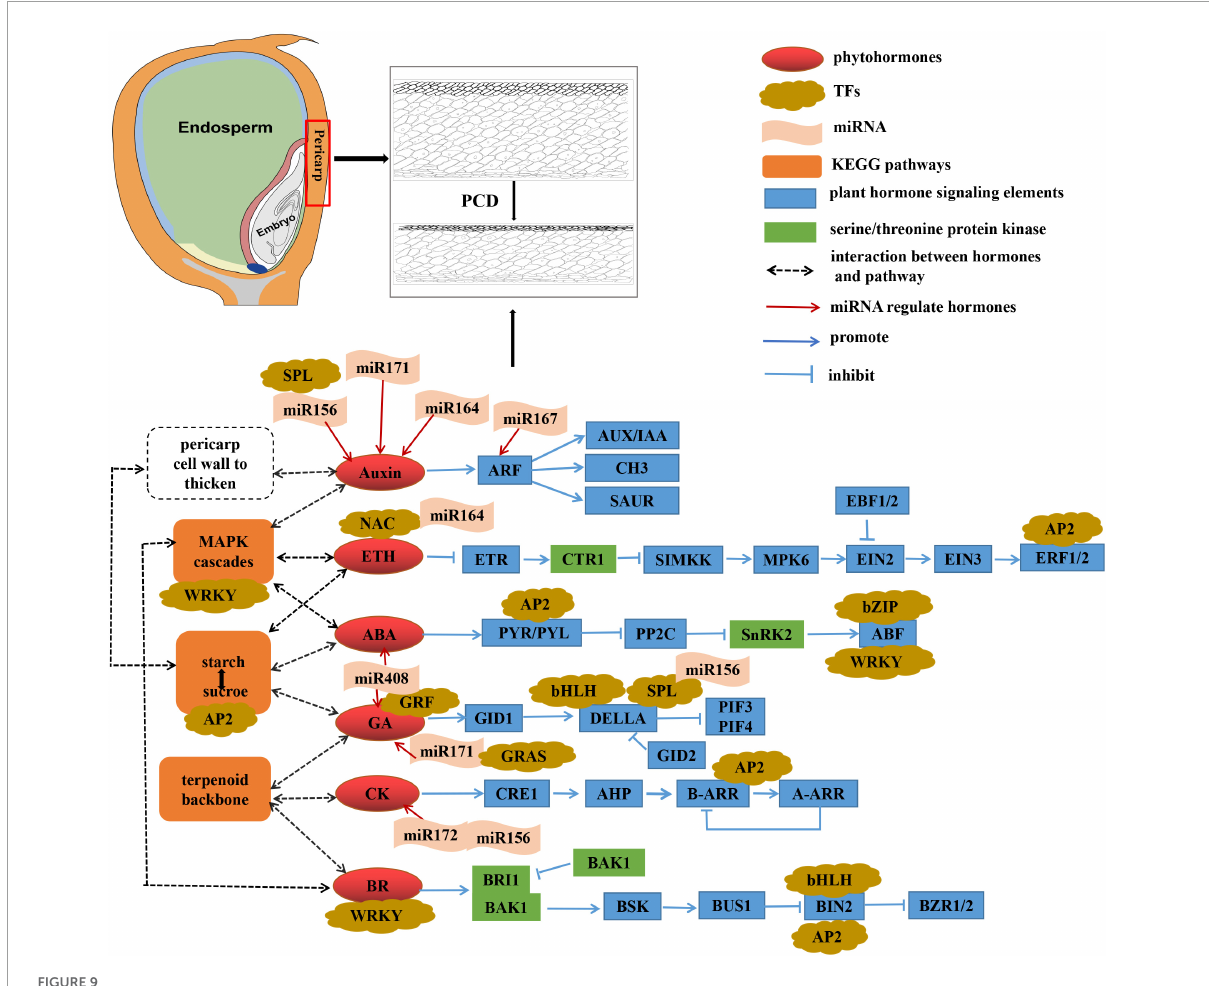
FIGURE9 Hypothetical mechanisms regulating sweet corn pericarp